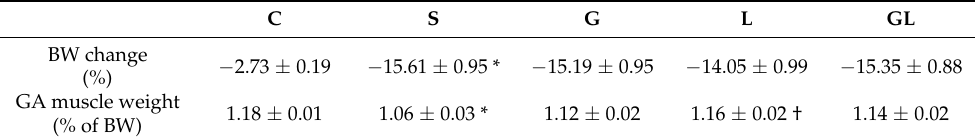
Table 1. Body weight (BW) changes and gastrocnemius (GA) muscle